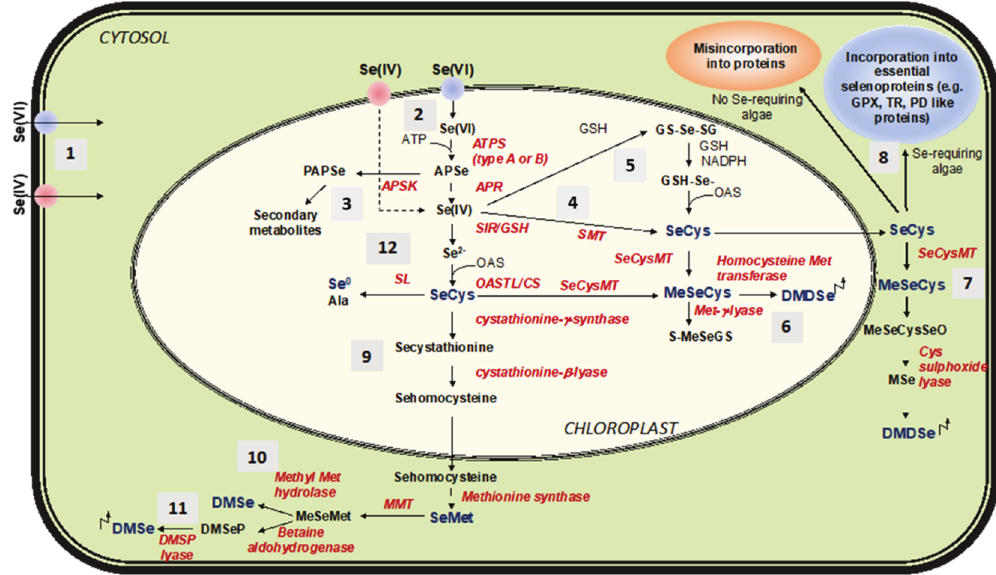
Figure 8. Schematic representation of the metabolic fates of Se in phototrophic organisms (plants and algae). (1) Selenate (Se(VI)) and selenite (Se(IV)) are the main forms of Se in aquatic environment taken up by algae. Once they have entered the cytosol, both ions are transported to the chloroplasts to be incorporated into selenocysteine (SeCys). (2) SeCys can be produced from Se(VI) through the sulfur assimilation pathway, which involves the enzymes Adenosine Triphosphate (ATP) Sulfurylase (ATPS), Adenosine Phosphosulfate Reductase (APR), and Sulfite Reductase (SiR). (3) Activated Se(VI) (Adenosine Phosphoselenate, APSe) can be phosphorylated by Adenosine Phosphosulfate (APS) Kinase (APSK) to produce Phosphoadenosine Phosphoselenate (PAPSe), which is a precursor of secondary Se-containing metabolites. (4) Se(IV) can be converted to SeCys directly by Selenomethyl Transferase (SMT). (5) Alternative pathway of Se(IV) reduction and SeCys synthesis involves glutathione (GSH), with selenodiglutathione (GS-Se-SG) produced as an intermediate. (6) SeCys can be methylated by Selenocysteine Methyl Transferase (SeCysMT) to form Methyl Seleno Cysteine (MeSeCys), which can be further converted to Dimethyl Diselenenide (DMDSe) through the action of Homocysteine Methyl transferase. SeCys can be transported outside the chloroplast and be either (7) methylated to produce MetSeCys and DMDSe or (8) incorporated into proteins (via a specific mechanisms in Se-requiring microalgae). SeCys in the chloroplast can be converted to Selenohomocysteine, which is then transformed into Selenomethionine (SeMet) once delivered to the cytosol. (9) SeMet can be methylated to produce Methylselenomethionine (MeSeMet), which is further converted to Dimethyl Selenide (DMSe) by either (10) methyl methionine hydrolase or (11) Dimethylselenopropionate lyase (DMSP lyase). SeCys can also be broken into Alanine (Ala) and elemental Se (Se 0 ) by the activity of Selenocysteine lyase (SL). OAS: O-acetyl serine, OASTL / CS: OAS Thiol lyase / Cysteine synthase, S-MeSeGS: S-Methyl-selenoglutathione, Υ ECS: γ Glutamyl Cysteine Synthetase, GluMeSeCys: Glutamylmethylselenocysteine, MMT: Methionine Methyl Transferase, DMSP: Dimethylselenopropionate, MeSeCysSeO: Methylselenocysteine Methaneseleniol.